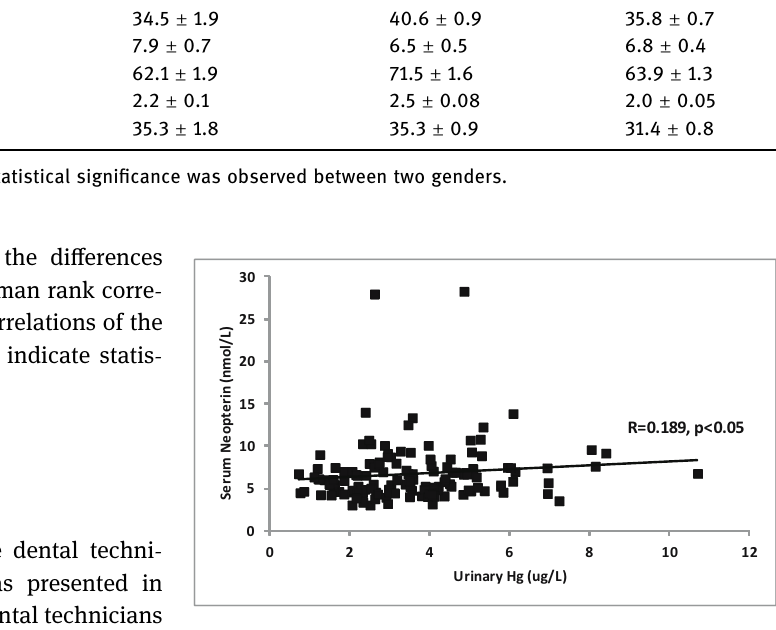
Figure 2: Correlation between urinary Hg and serum neopterin levels of dental